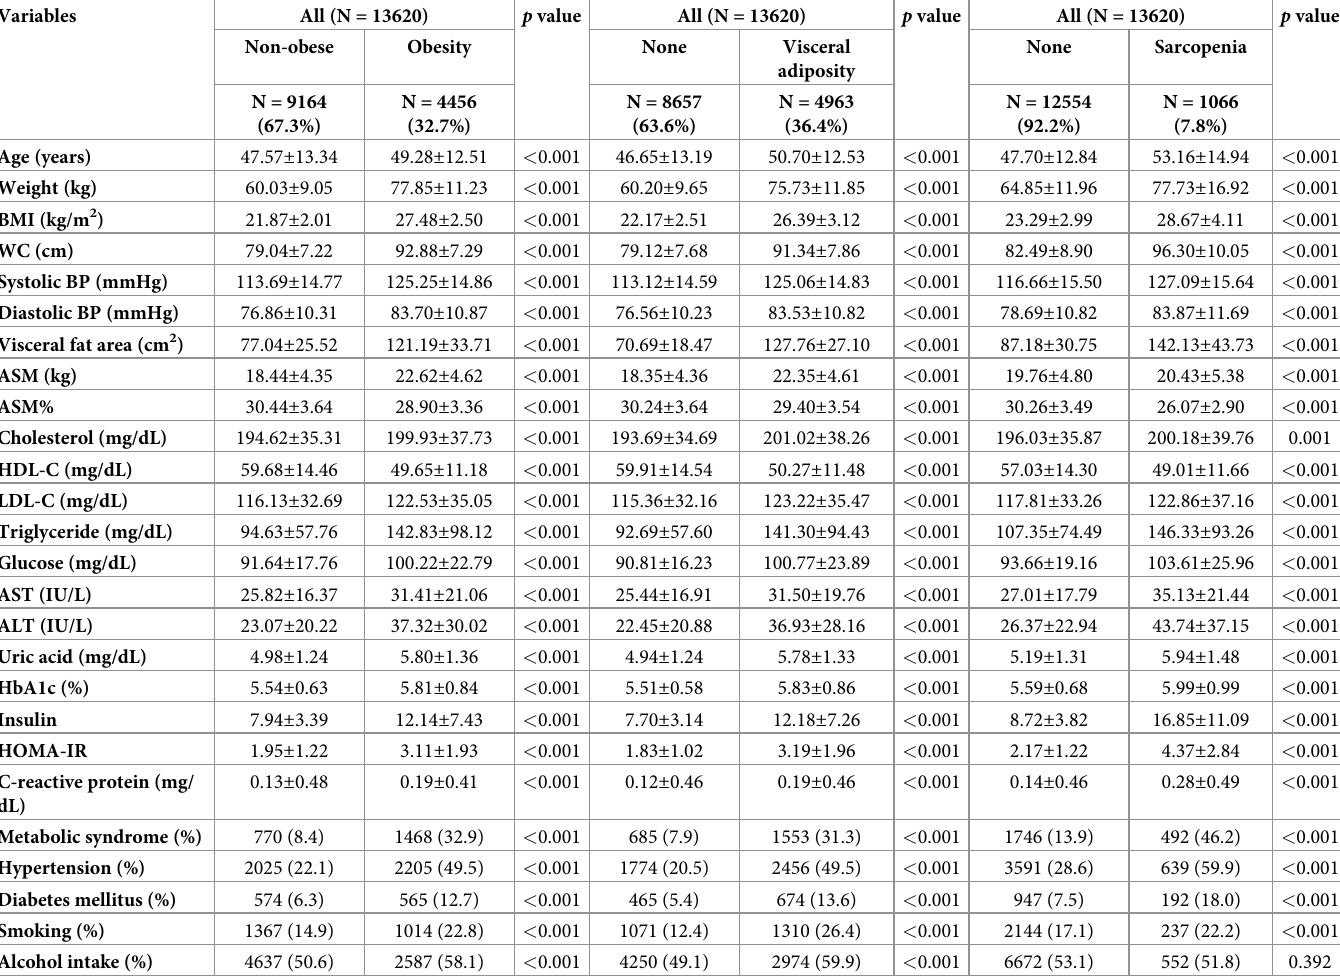
Table 2. Clinical characteristics according to obesity, visceral adiposity, and sarcopenia